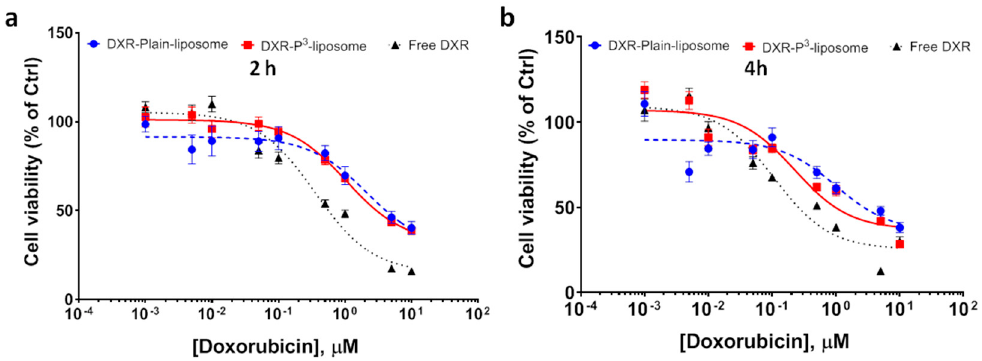
Figure 9. Dose–response curves of free doxorubicin, doxorubicin-P 3 -liposomes, and doxorubicin-Plain-liposomes in LNCaP cells. The cells were exposed to liposomes for ( a ) 2 h and ( b ) 4 h.